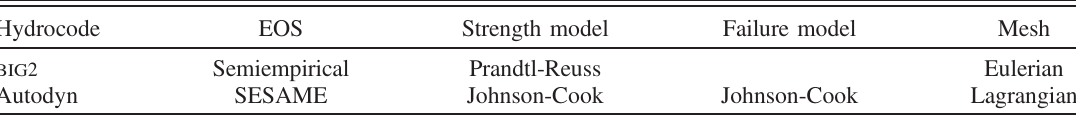
I. Material constitutive models and meshes employed by the